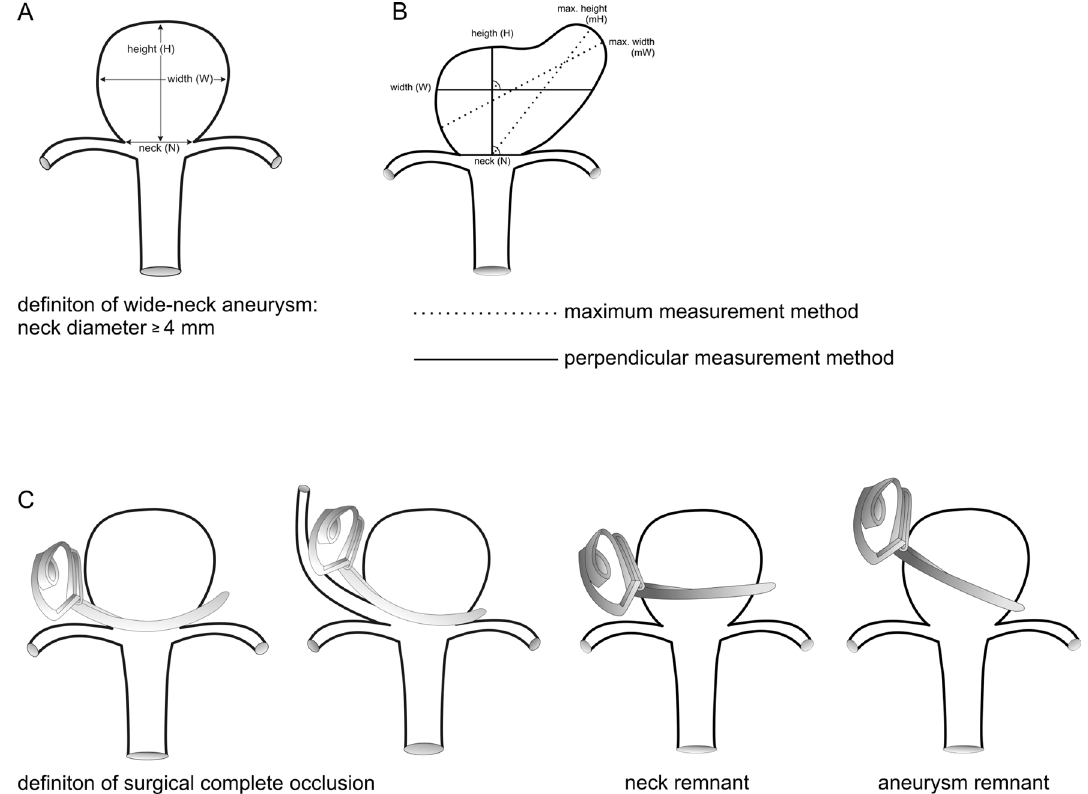
Figure 2. ( A ) Definition of wide neck aneurysm. ( B ) Differentiation between saccular perpendicular- (simple) and non-saccular non-perpendicular (complex) aneurysm. If width or height deviation was ≥ 2 mm, it was defined as a complex aneurysm. ( C ) Definition of Raymond-Roy occluding grade: complete, neck- and aneurysmal